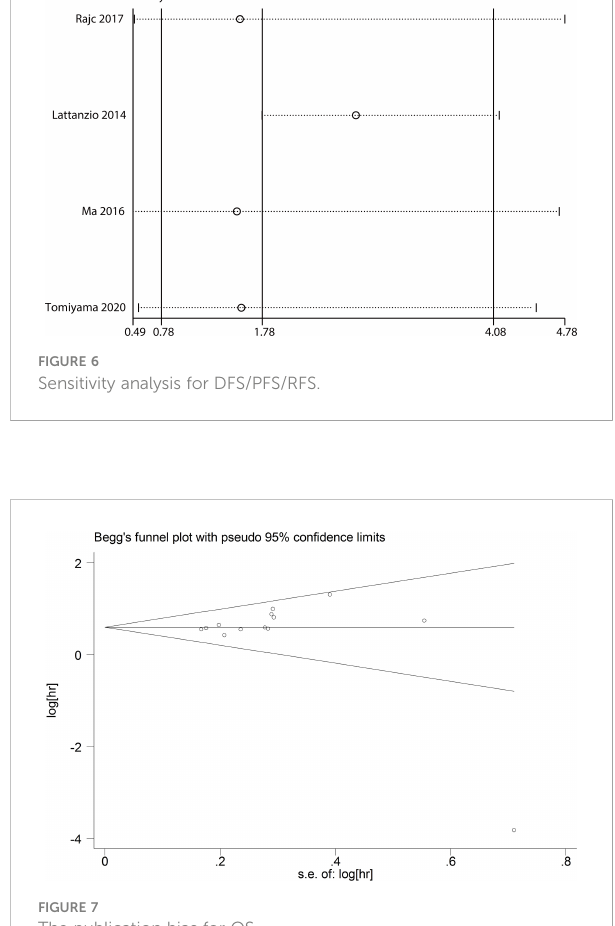
FIGURE 7 The publication bias for OS.